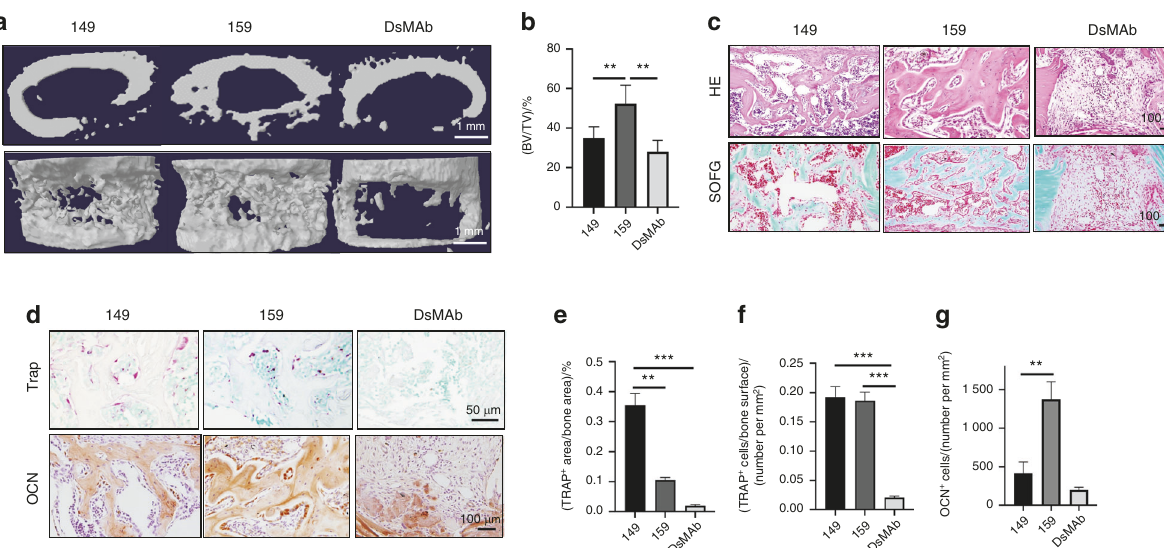
Fig. 7 Injection of the Siglec-15 neutralizing antibody promoted fracture healing. All data in this fi gure are derived from 5-month-old C57BL/6 mice that underwent semiosteotomy at 3 months old and were treated with NP-149 (control antibody) or NP-159 (Siglec-15 neutralizing antibody 2) for 1 month after surgery. a Representative three-dimensional µCT images of the bone defect area in the mouse femurs. b Quantitative analysis of the µCT scan in a . n = 5, ** P < 0.01. c Representative images of hematoxylin and eosin (HE staining (top row) and safranin O fast green (SOFG) staining (bottom row) of the bone defect in mouse femurs. d TRAP staining (top row) and immunohistological staining of osteocalcin (OCN) (brown, bottom row) in the bone defect area in mouse femurs. Quantitative analysis of the number ( e ) and area ( f ) of TRAP + cells in the bone defect area. n = 5, ** P < 0.01, *** P < 0.001 . g Quantitative analysis of the number of OCN + cells in the bone defect area. n = 5, ** P <